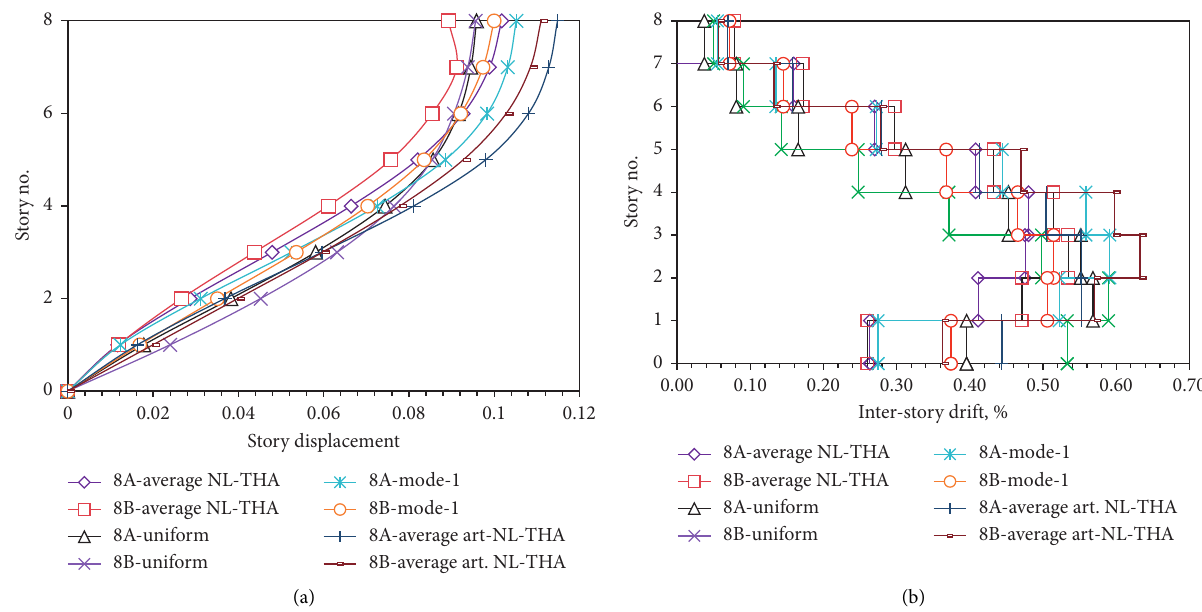
Figure 8: (a) Roof drift and (b) interstory drift for 8-story frame of 8A and 8B model